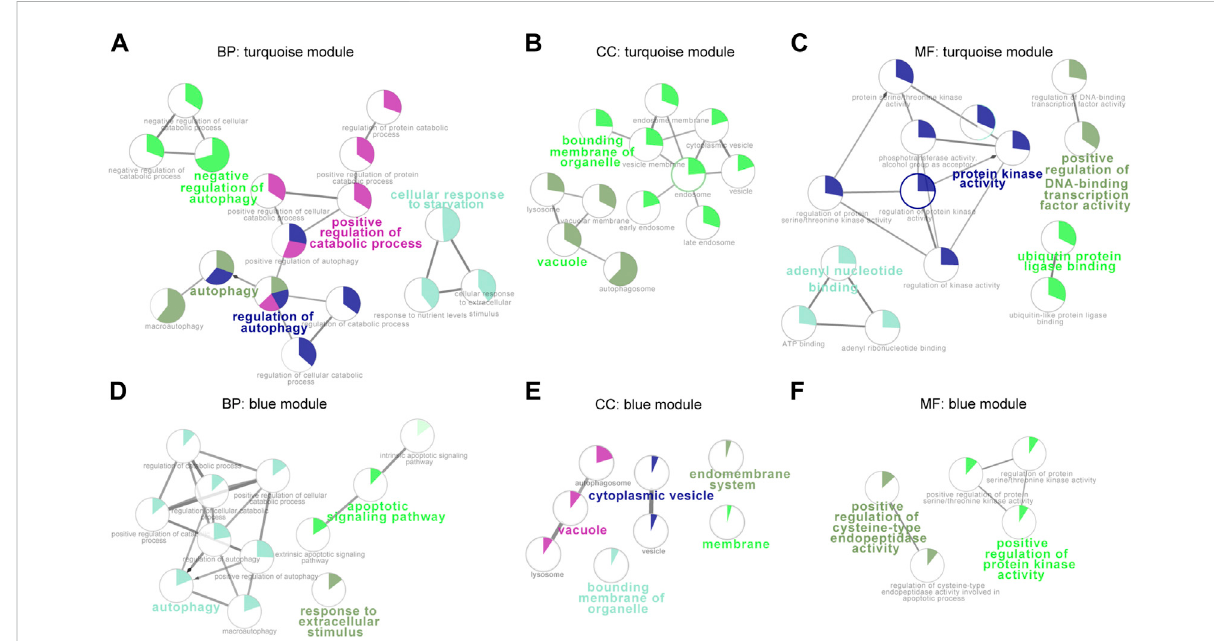
FIGURE 2 Functionalenrichmentanalysisoftheblueandturquoisemodules.Over-representedGO/pathwaytermswereevaluatedbasedonkappavalue. The sector size of each category within a pie chart indicates the number of enriched genes. GO/pathway terms are represented as nodes, and the node size highlight the term enrichment signi fi cance. Genes in turquoise and blue modules were annotated by biological processes (A , D) , cellular components (B , E) , and molecular functions (C , F) . BP, biological processes; CC, cellular components; MM, molecular